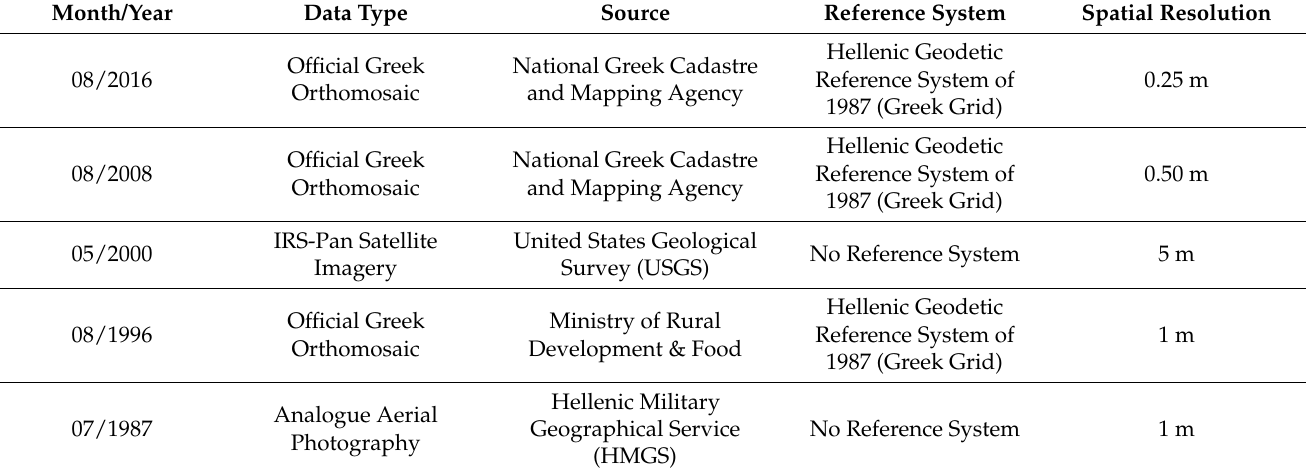
Table 1. Datasets used in current